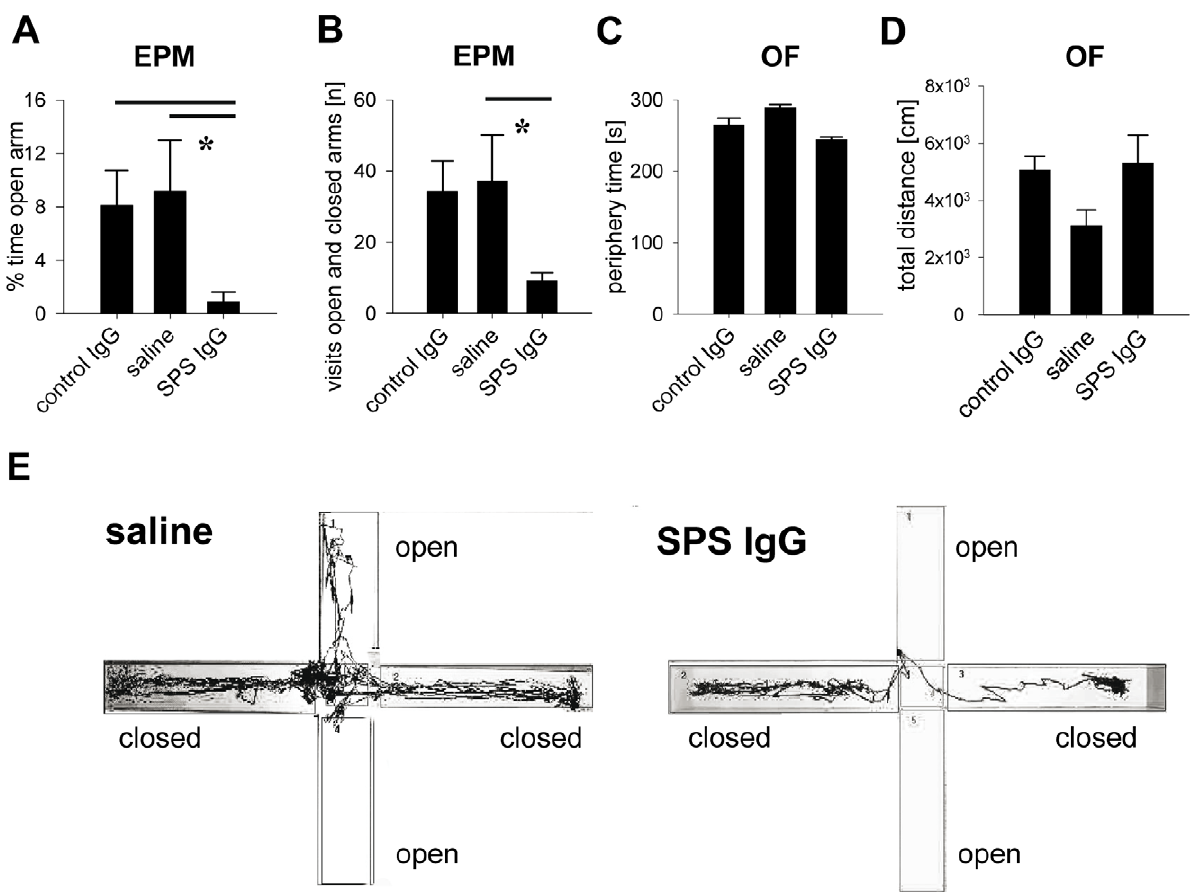
Figure 2. SPS patient IgG induces anxiety-like behavior. (A and B) Animals after intrathecal passive transfer of IgG were tested on an elevated plus maze (EPM) to analyze anxiety-like behavior. Rats treated with SPS patient IgG (SPS IgG; n=6) moved normally but spent significantly less time in the open arms and explored significantly less arms of the EPM in testing period compared to controls (control IgG: n=9; saline n=7), indicating increased anxiety-like behavior (* p , 0.05; Mann-Whitney Test). (C and D) Locomotor activity, assessed as time spent in the periphery of the open field (OF) and total distance moved during the observation period, was not different between the experimental groups and did not contribute to the behavioral observations in the EPM. (E) Representative tracks of a rat treated with saline (left panel) and SPS IgG (right panel) in the EPM. Whereas the control animal explored 3 arms of the EPM including one open arm with bright illumination, the rat treated with SPS IgG stayed in the closed, darker arms and avoided entries into the open arms.